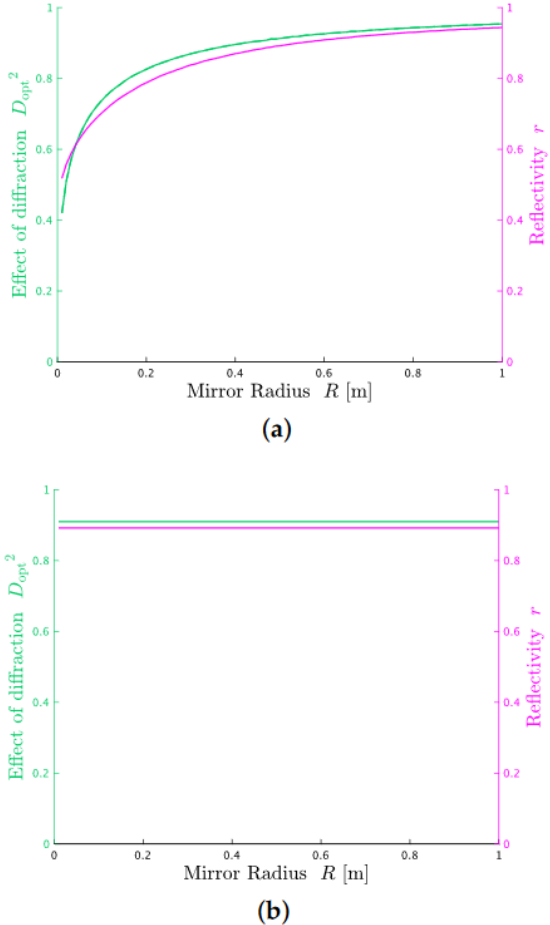
Figure 9. Optimized effects of diffraction D opt2 (green line) and reflectivity r (magenta line) for a given R in the case of constant thickness ( a ) and in the case of constant mass ( b ). Both figures show the plotted D opt 2 is similar to that of r